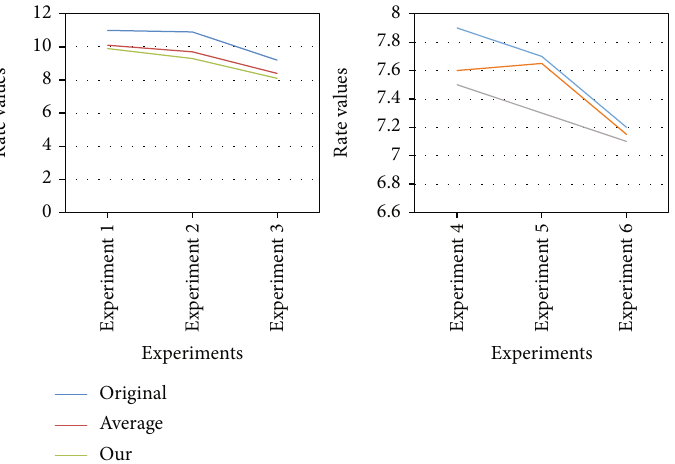
Figure 5: Error rate of football injury identi fi cation.